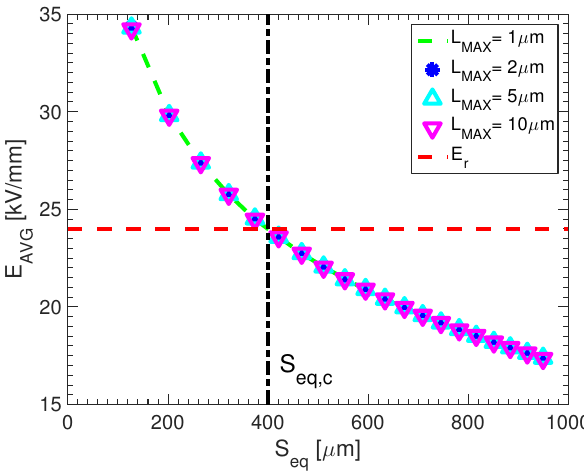
Figure 7: Average electric field as a function of the con- trol volume equivalent cubic side S eq = Ω 1 / 3 . The critical equivalent cubic side S eq , C is the S eq where E AVG = E r .